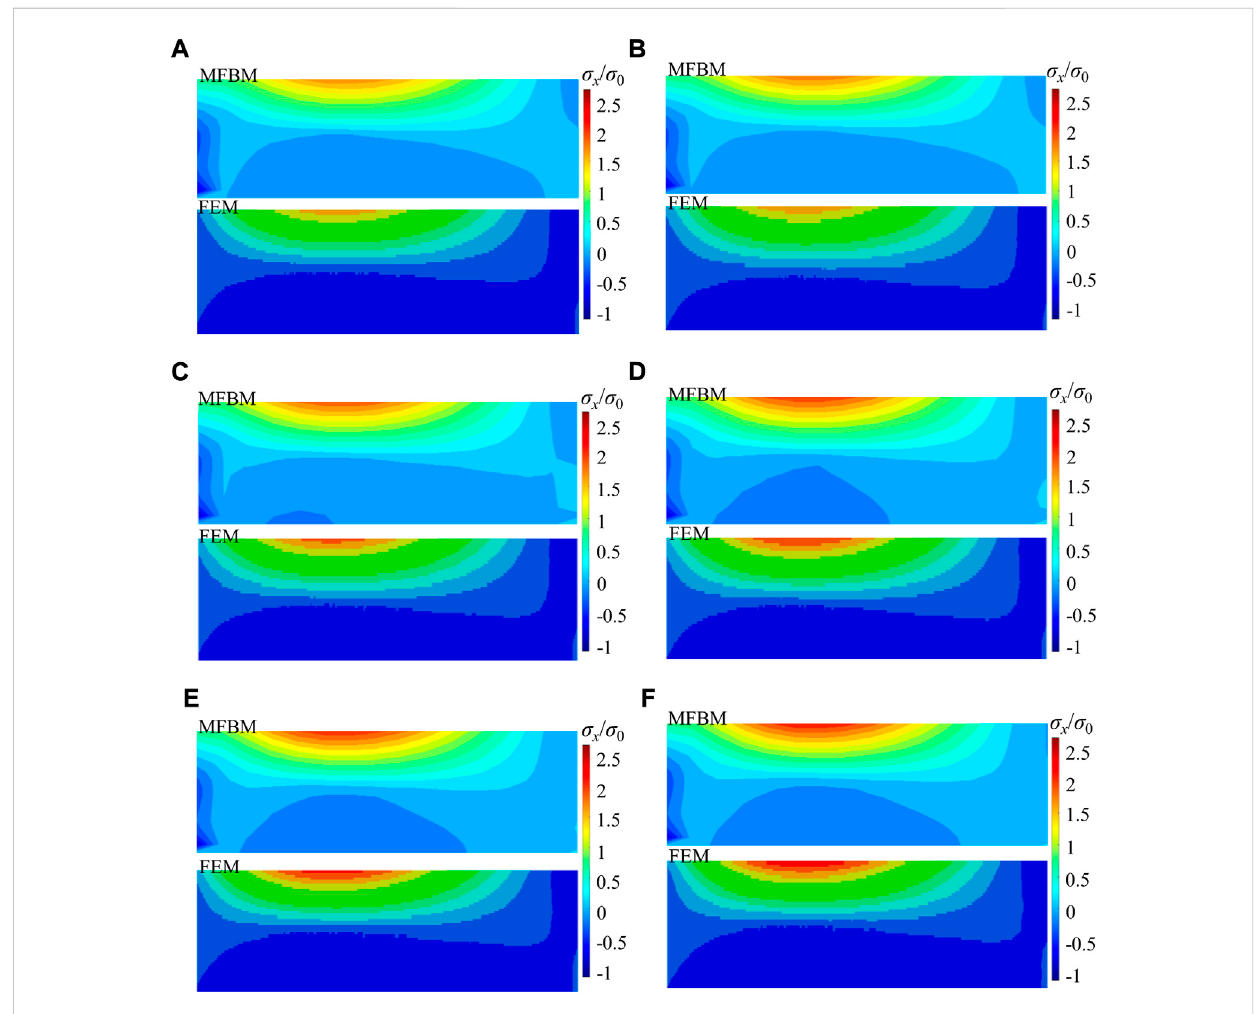
FIGURE 10 Maximum principalstress/loadgradient distributions withh1 =25 cm andh2 =20 cm: (A) a = b= 0 cm; (B) a=20 cmand b= 40 cm; (C) a=40 cm and b = 80 cm; (D) a = 60 cm and b = 120 cm; (E) a = 80 cm and b = 160 cm; (F) a = 100 cm and b = 200 cm.